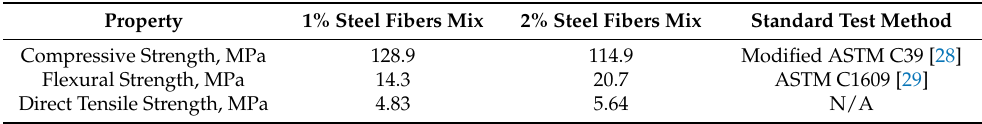
Table 2. Main Mechanical Properties Tested at 28 days for the NP-UHPC